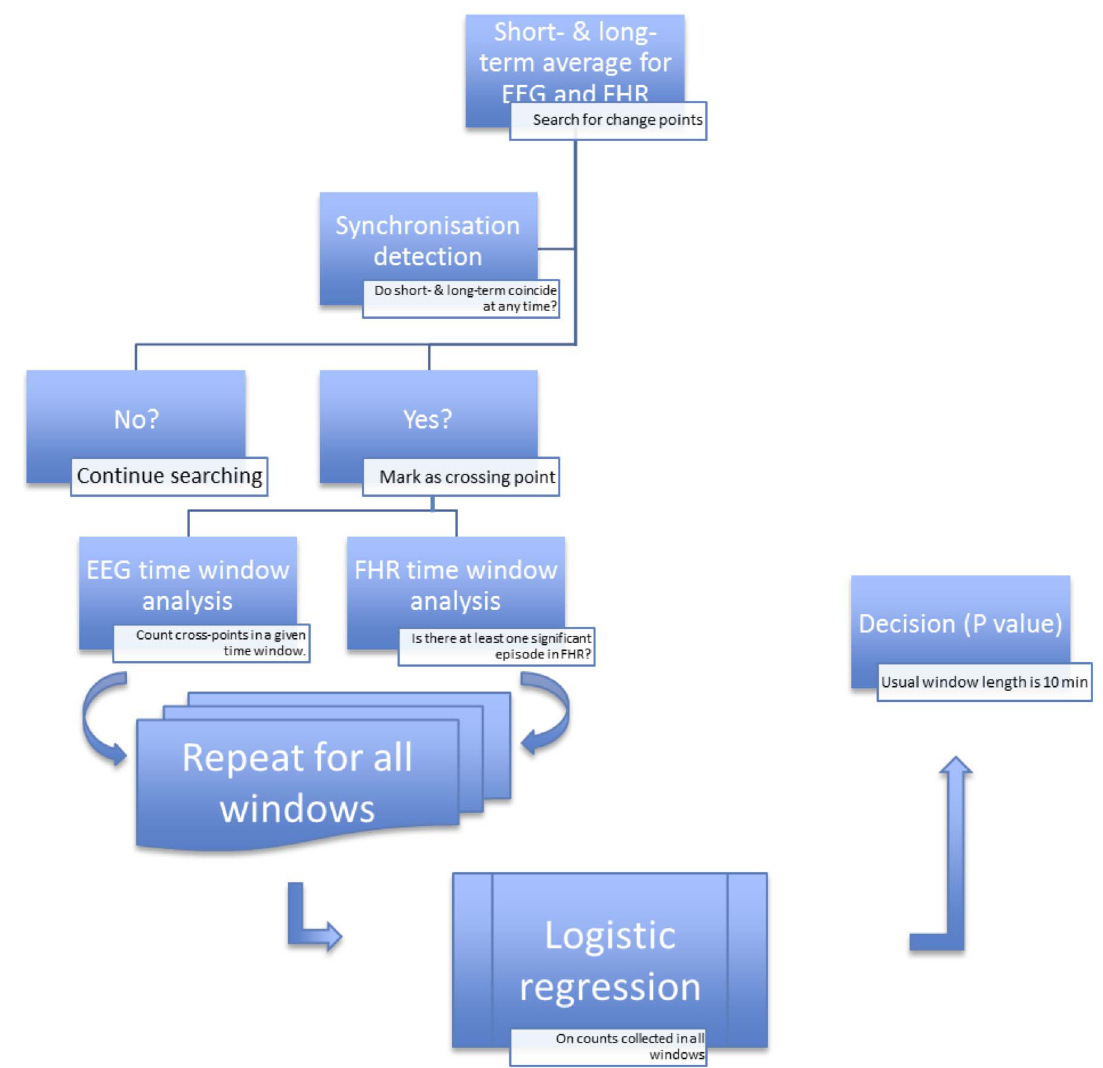
Figure 1. The algorithm to detect EEG-FHR synchronisation.